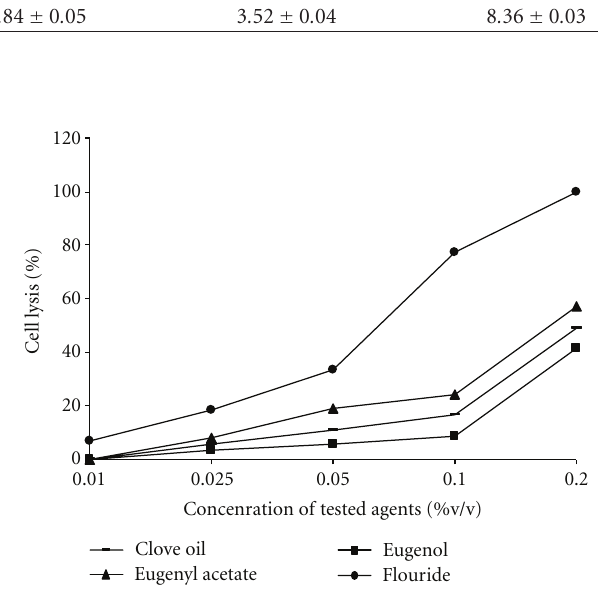
Figure 3: Hemolysis caused by di ff erent agents: clove oil, eugenol, eugenyl acetate, and fluoride. Hemolysis was determined by an absorbance reading at 450nm and compared to hemolysis achieved with 1% Triton X-100 (reference for 100% hemolysis). The data are means of triplicate